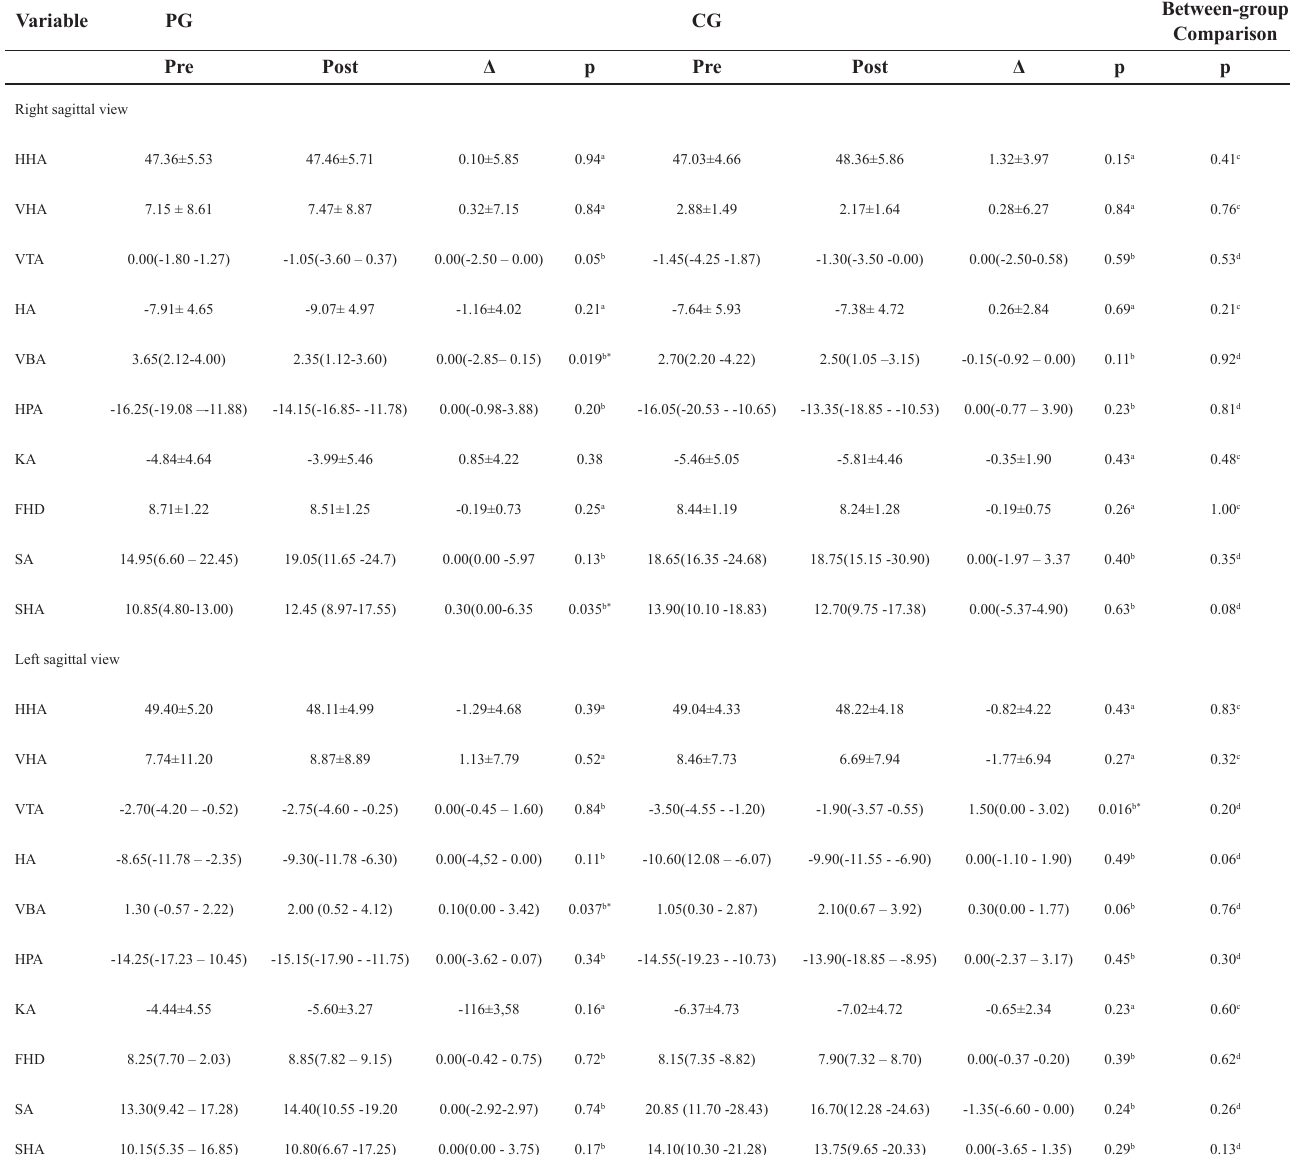
SHA * p< 0,05. P-value according to the T-test (paired) a or Wilcoxon test b for intragroup comparisons, T-test (unpaired) c or Mann-Whitney test d for between- groups comparisons. Results are presented as mean ± standard deviation or median and quartiles.